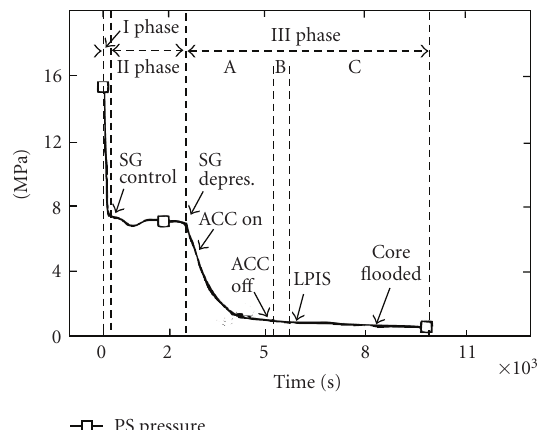
Figure 7: ISP 27 (BETHSY): experimental trend of primary side